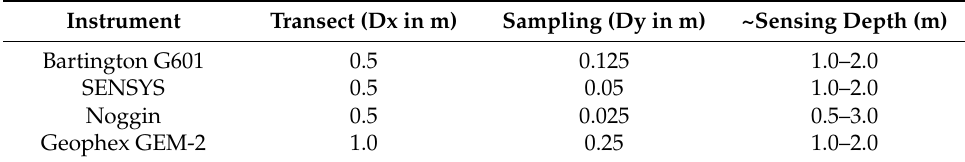
Table 1. The instrumentation of the IGEAN project and their parameter